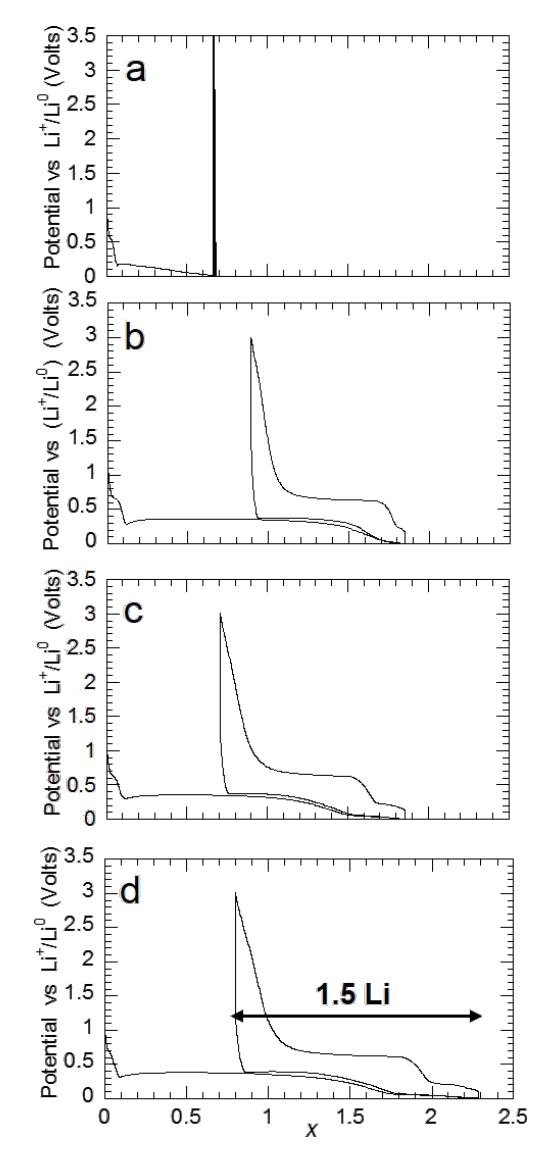
Figure 17: Evolution of the potential (V) as a function of x (mole frac- tion of Li) for MgH 2 electrodes cycled between 3 and 0.005 V at a rate of one equivalent of lithium in 10 h. a) MgH 2 commercial hydride; b) MgH 2 commercial hydride ground for 4 h with 10% of C t , z carbon; c) MgH 2 after one absorption of hydrogen and then ground for 4 h with 10% of C t , z carbon; d) MgH 2 after three absorptions of hydrogen and then ground for 4 h with 10% of C t , z carbon [11].